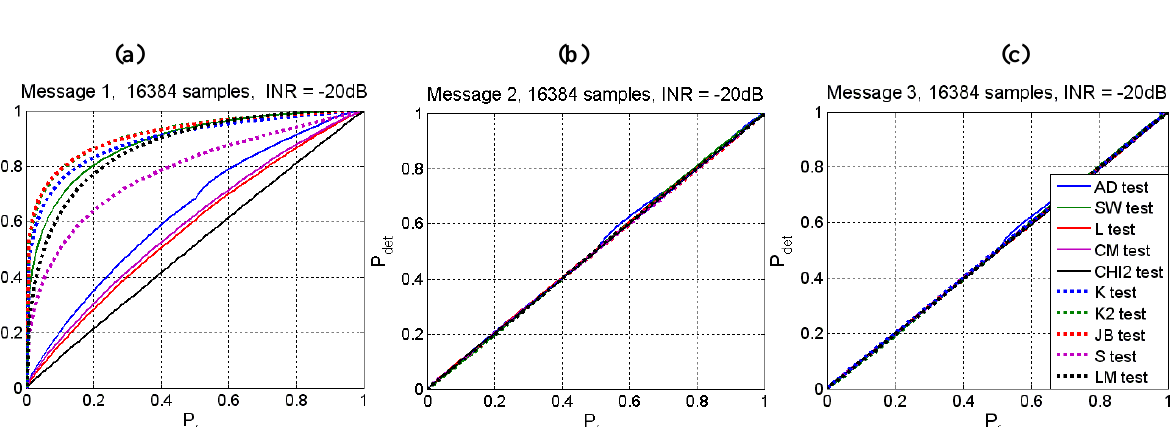
Figure 12. Normality test performance in the detection of a telegraphic interference signal. ROC curves of the different tests are presented in function of 3 different messages, setting the sample size to 16,384 and INR to − 20 dB. The best normality tests for detecting message 1 is JB and K2 tests as both values of Kurtosis and Skewness are non-zero. In the cases of message 2 and 3, both compressed data (zip and jpg archives), − 20 dB is a very low INR to detect these messages so, in Figure 13, INR is set to -5.2dB. Results obtained from a Monte-Carlo set of 2 15 simulations.